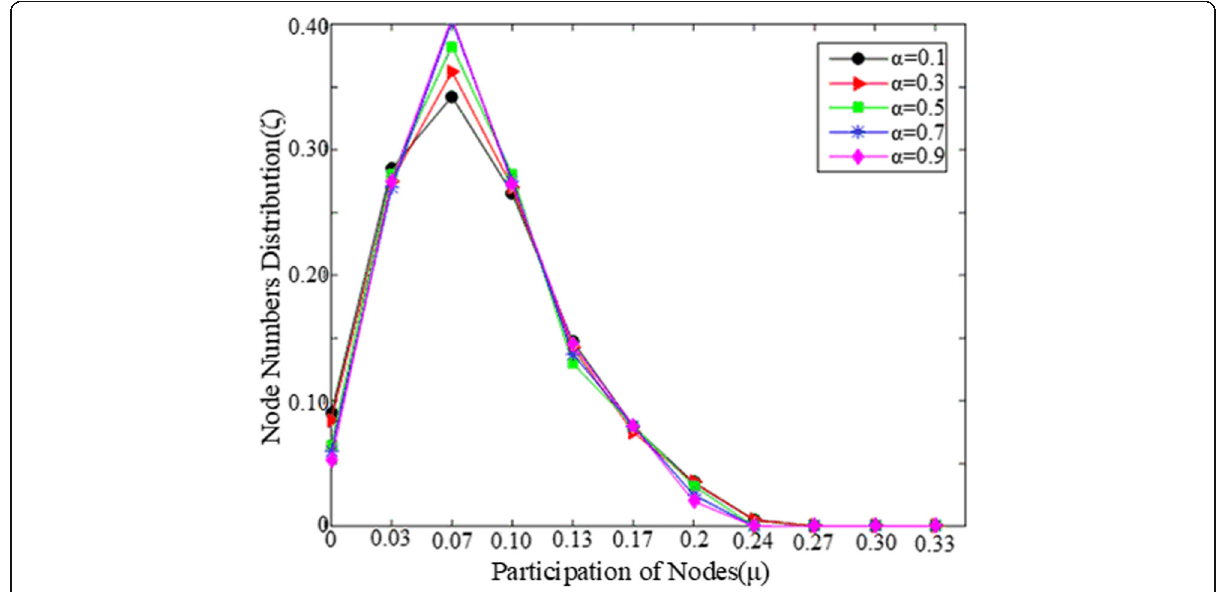
Fig. 10 Comparison of node participation equality of LCBPA with different trade-off parameter α when k = 20, N =